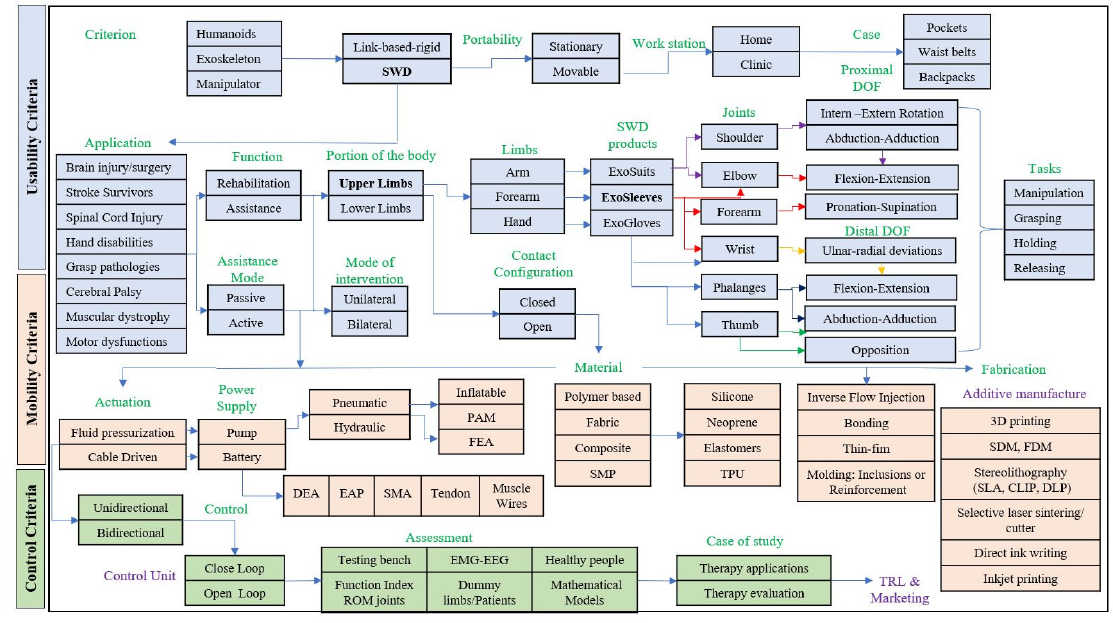
Figure 4. State machine of soft wearable devices.